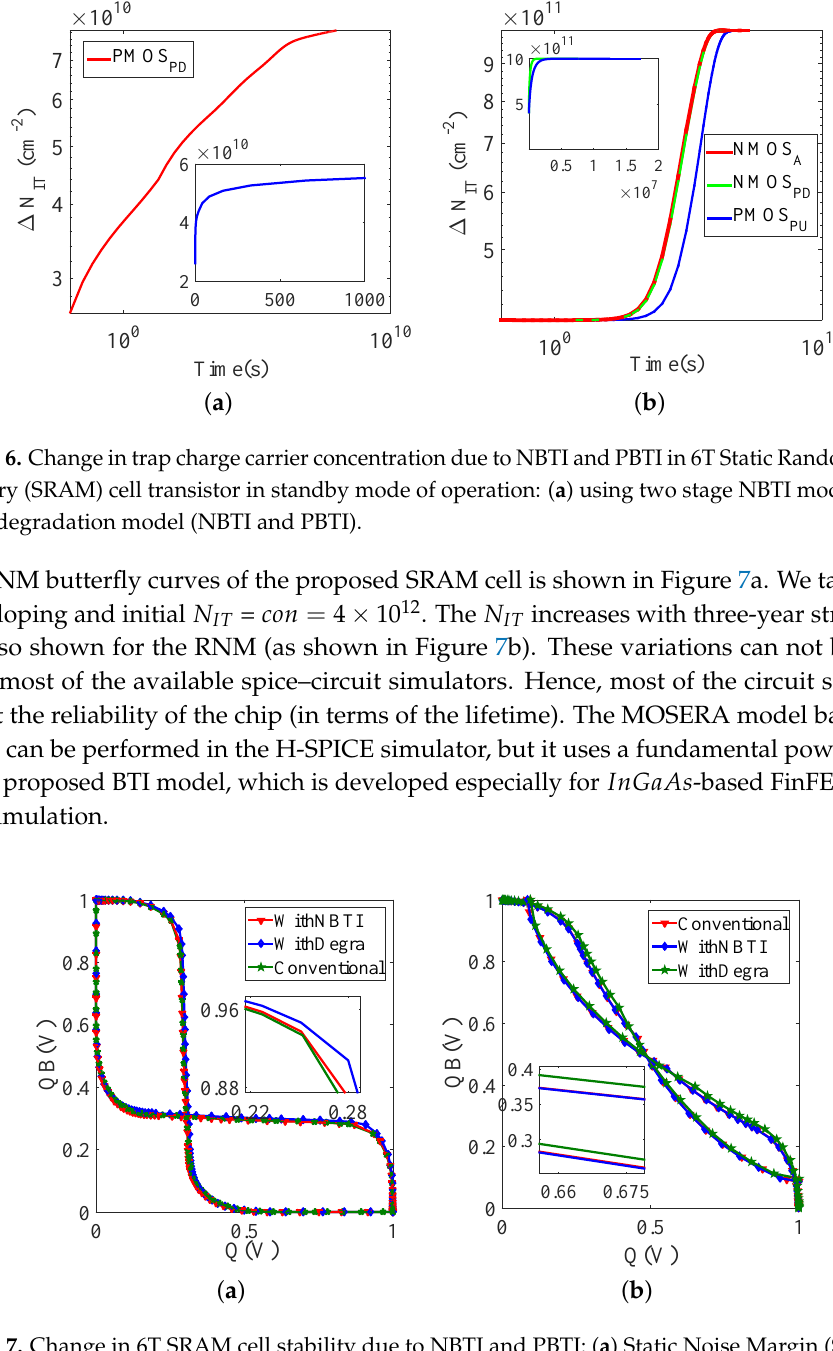
Figure 7. Change in 6T SRAM cell stability due to NBTI and PBTI: ( a ) Static Noise Margin (SNM) and ( b ) Read Noise Margin